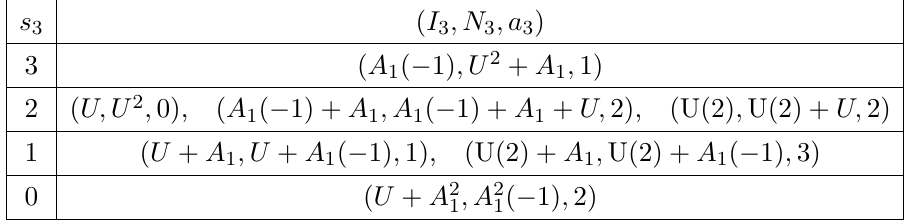
Table 3 . Invariant and normal lattices embedded in U 3